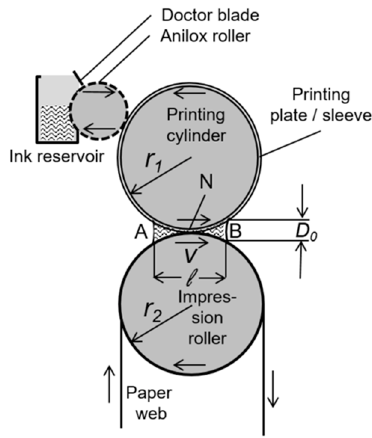
Figure 4. Sketch of a flexographic printing unit. The zones A and B represent the incoming and outgoing ink meniscus, respectively, N is the printing nip, D 0 is the meniscus height, ℓ is the width of the wetted zone. Reprinted from Reference [50], under the terms and conditions of the Creative Commons Attribution (CC BY) License (http://creativecommons.org/licenses/by/4.0/).